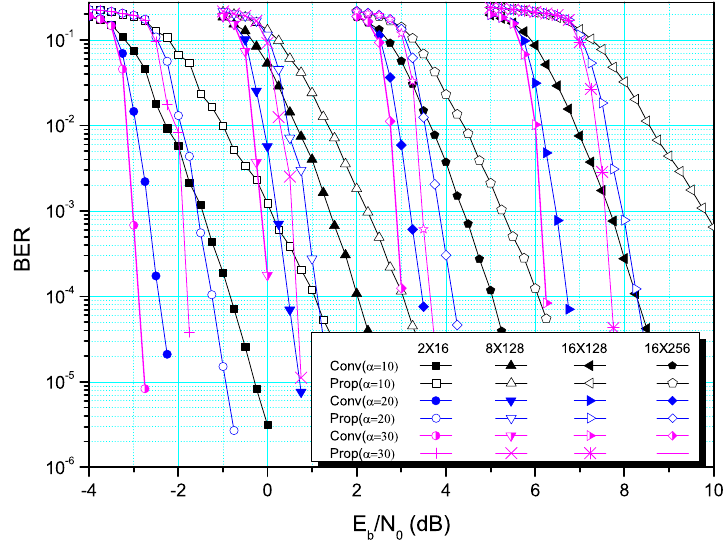
Figure 2. BER performance comparison according to α at the first